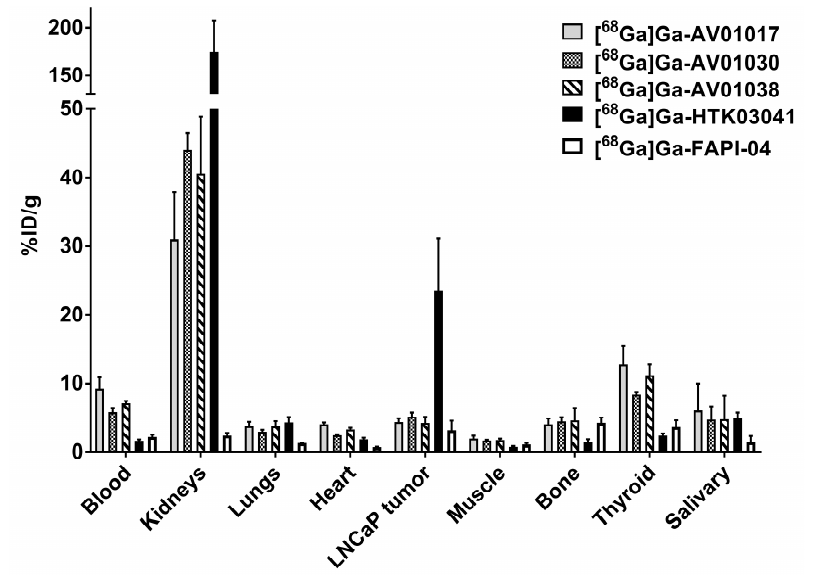
Figure 5. Biodistribution of [ 68 Ga]Ga-AV01017, [ 68 Ga]Ga-AV01030, [ 68 Ga]Ga-AV01038, [ 68 Ga]Ga-